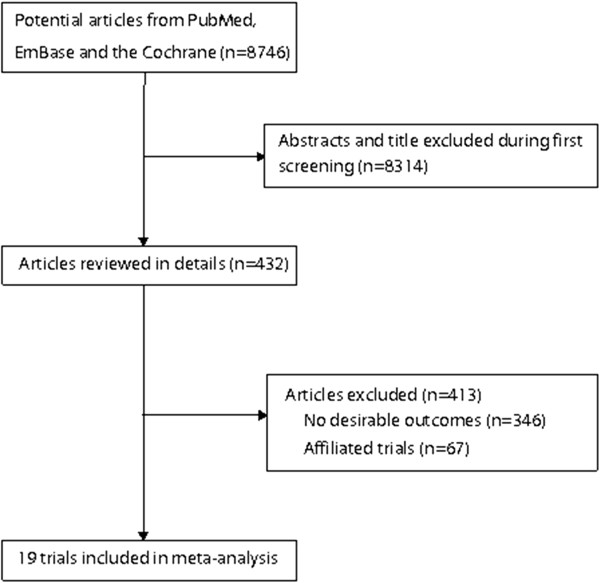
Flow diagram of the literature search and trials selection process.